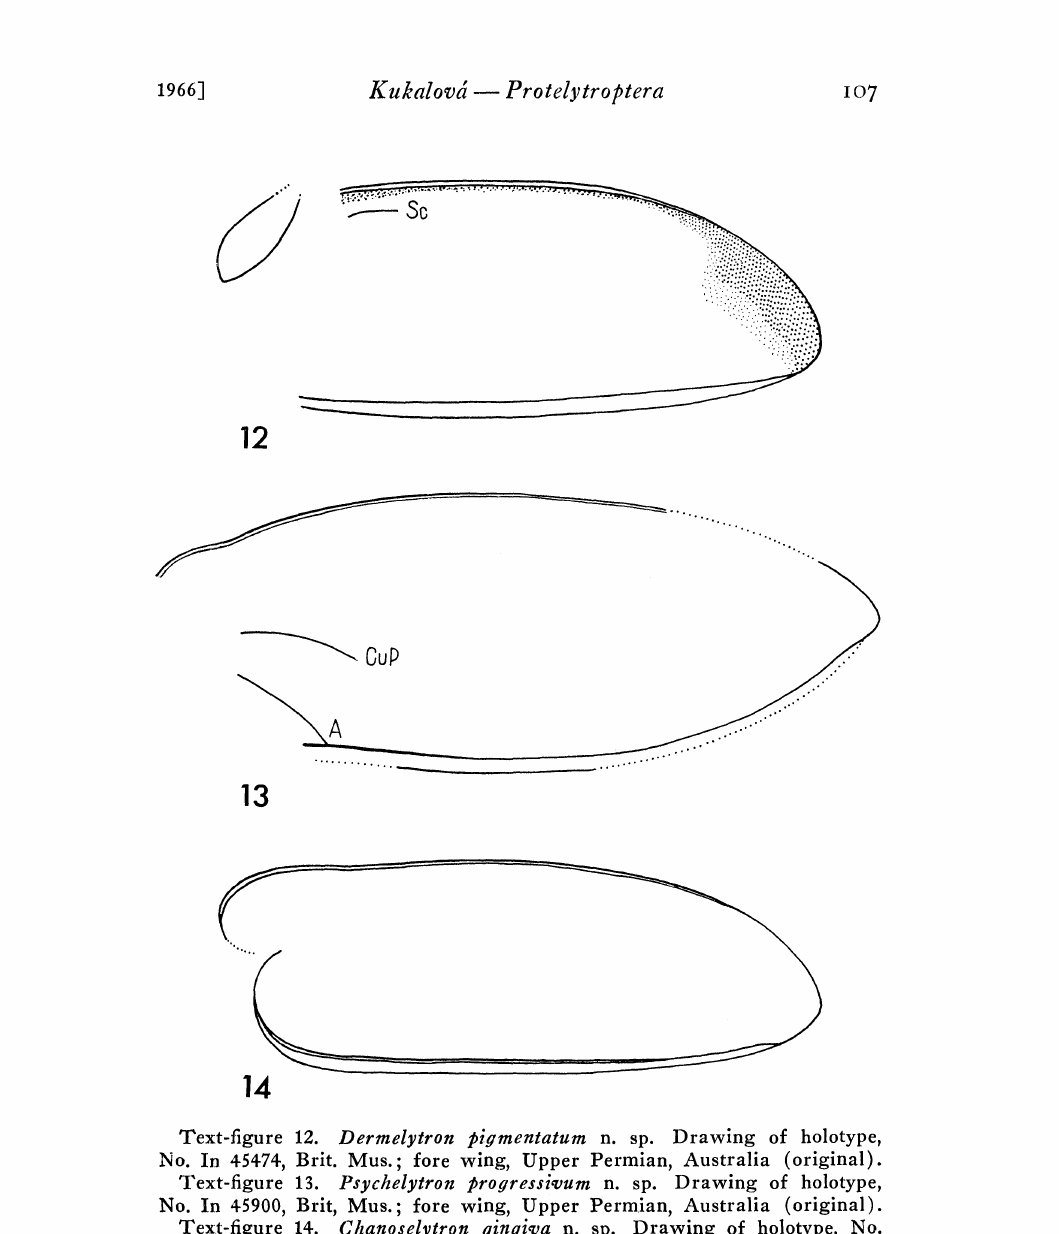
Text-figure 12. Dermelytron #igmentatum n. sp. Drawing of holotype, No. In 45474, Brit. Mus.; fore wing, Upper Permian, Australia (original). Text-figure 13. Psychelytron #rotressium n. sp. Drawing of holotype, No. In 45900, Brit, Mus.; fore wing, Upper Permian, Australia (original). Text-figure 14. Chanoselytron .aingiva n. sp. Drawing of holotype, No. In 45493, Brit. Mus.; ore wing, Upper Permian, Australia